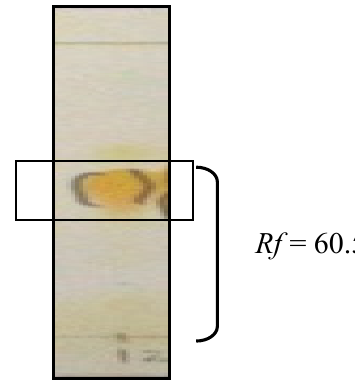
Figure 1. Thin layer chromatography (TLC) plate results of mitragynine (MG) using Dragendorff’s reagent and viewed with UV light microscopy.